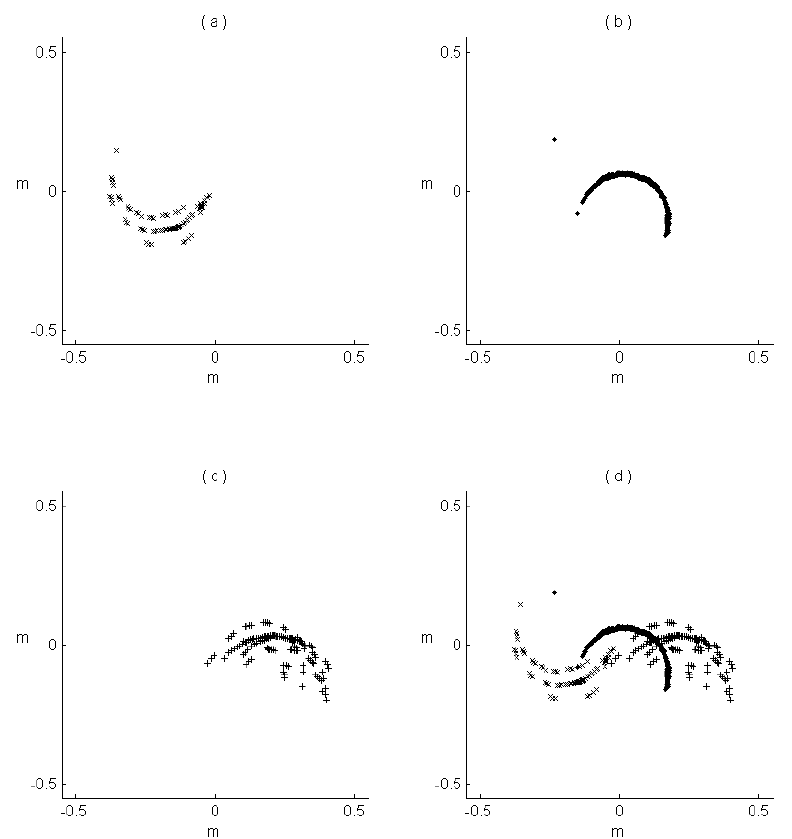
Figure 7. ( a – c ) The PLS points of a tree stem in a slice in three individual mapping paths and ( d ) in the merged